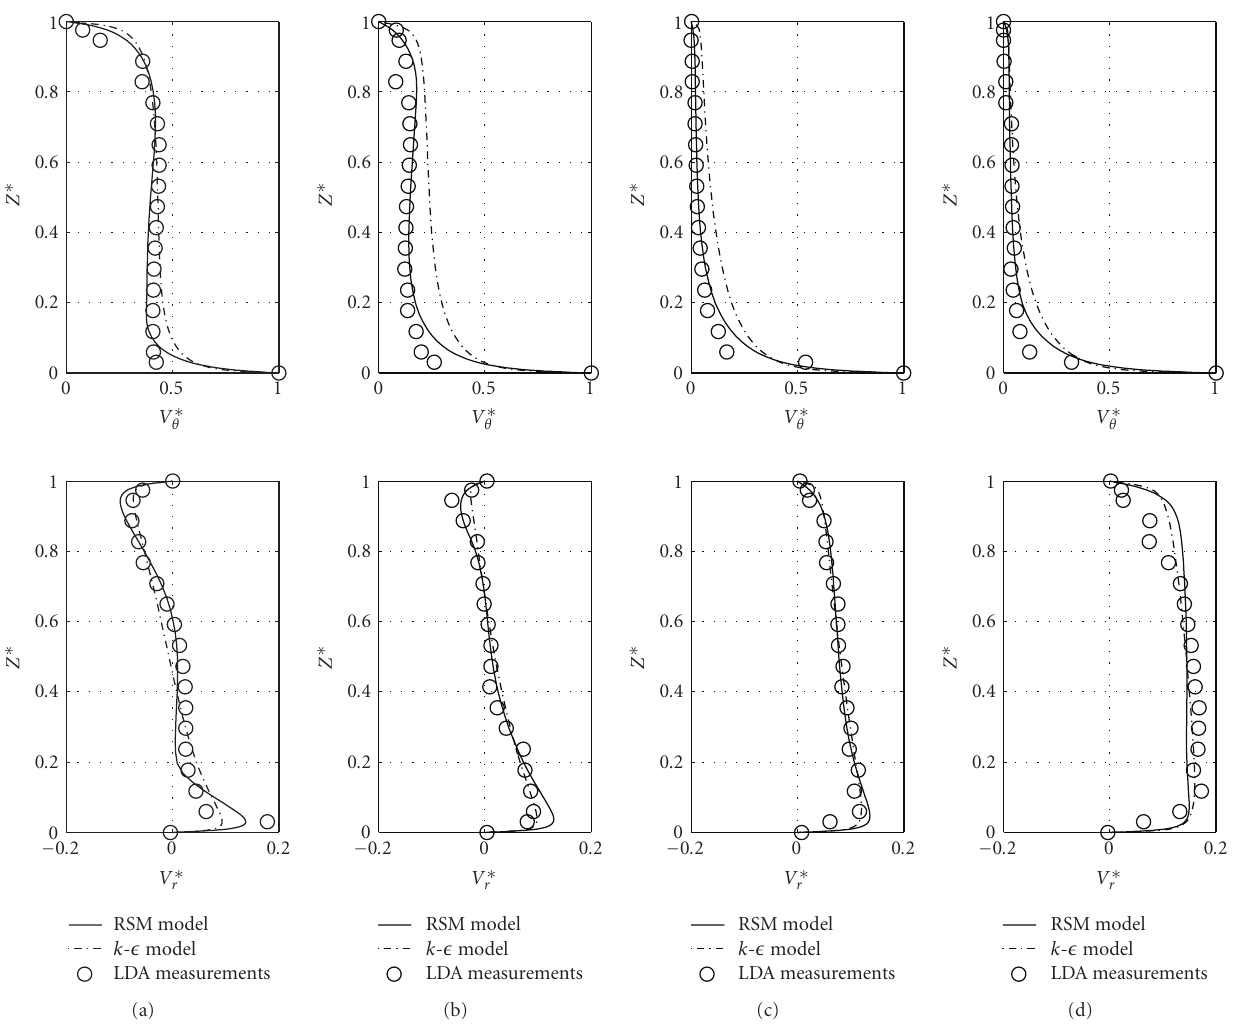
Figure 4: Axial profiles of two mean velocity components at r ∗ = 0 . 56 for G = 0 . 036 and Re = 10 6 with or without a centrifugal superimposed throughflow: (a) C w = 0, (b) C w = − 1976, (c) C w = − 5929, (d) C w = − 9881. Comparisons between the present RSM model ( − ), the k - (cid:2) model ( −·− ), and LDA measurements ( ◦ ).